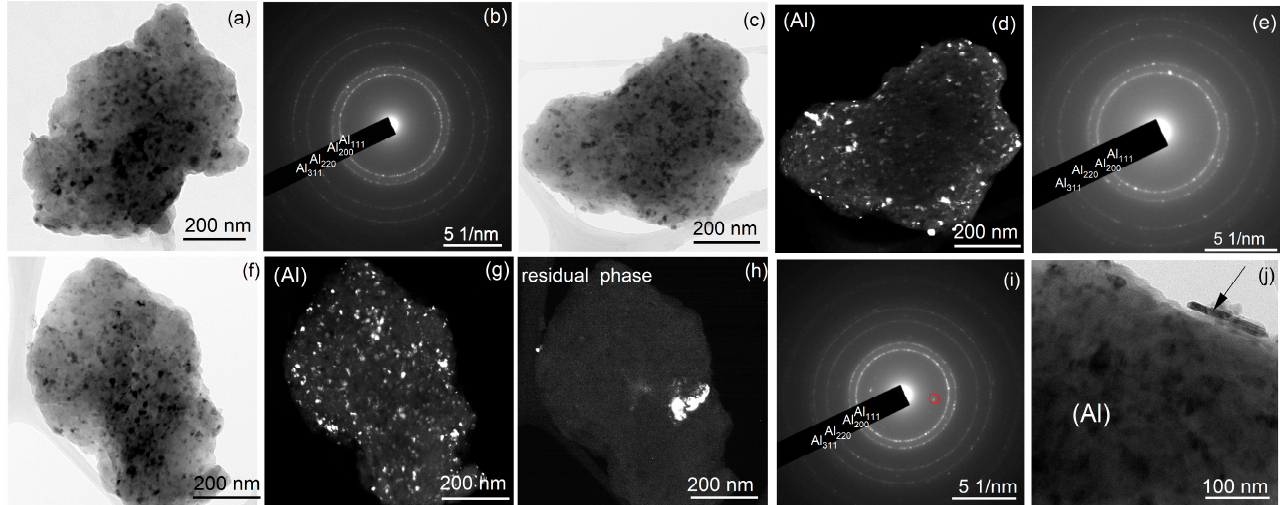
Figure 6. TEM structure of ( a , b ) sample A after milling for 20 h and ( c – j ) the pre-milled sample B after milling for ( c – e ) 20 h and ( f – j ) 40 h; ( a , c , f , j ) bright field images, ( d , g , h ) dark field images, and ( b , e , i ) the corresponding SAEDs; the red-colored ring in SAED ( i ) is the reflection for the dark field image presented in ( h ).